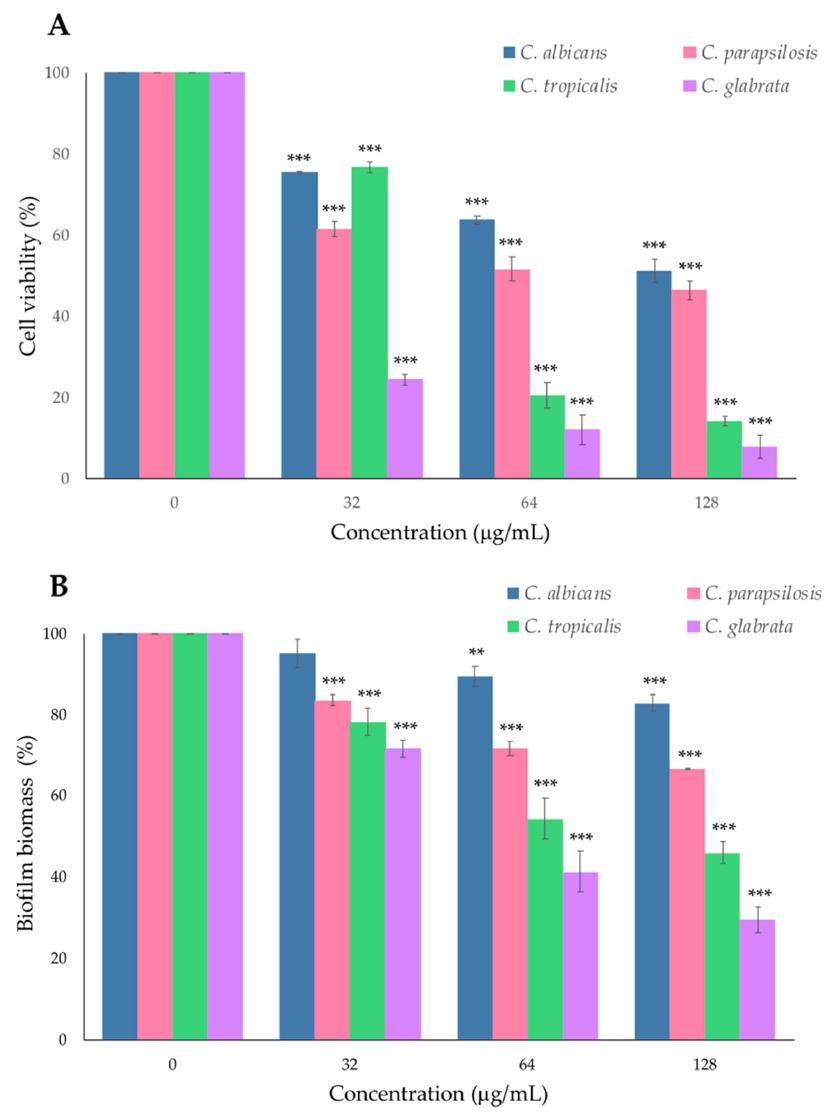
Figure 2. Eradication biofilm assay. The effect of treatment with 128, 64 and 32 µg/mL of PYED-1 on preformed biofilm of Candida species. The metabolic activities of biofilm cells ( A ) and biofilm biomass ( B ) were measured by XTT reduction assay and CV staining, respectively. All experiments were performed in triplicate. Asterisks indicate a statistically significant difference (** p -value ≤ 0.01 and *** p -value ≤ 0.001 from the nontreated controls without PYED-1).